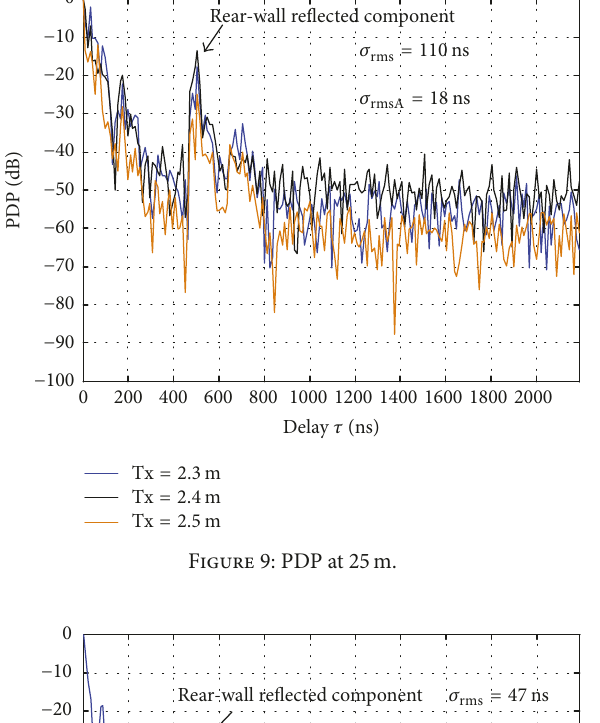
Figure 12: PDP at 75 m.